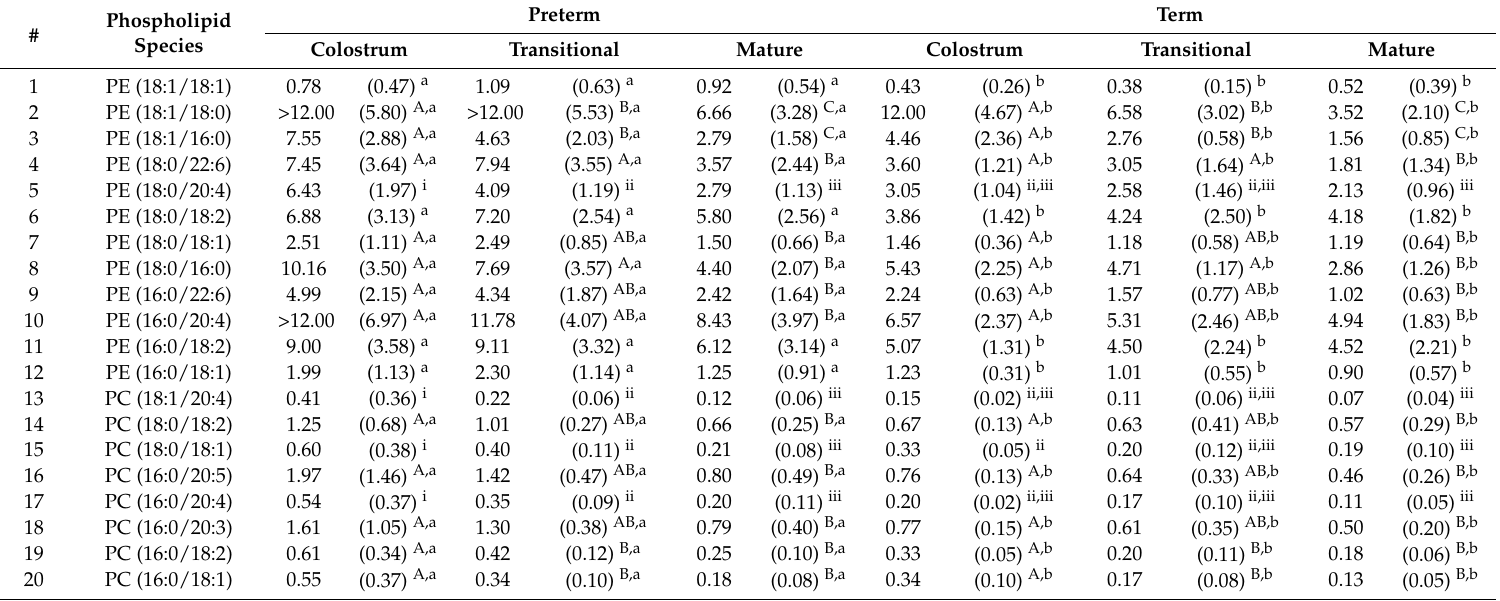
Table 2. Concentration (mg/100 mL) of phospholipid species in colostrum, transitional and mature milk from mothers with preterm and term